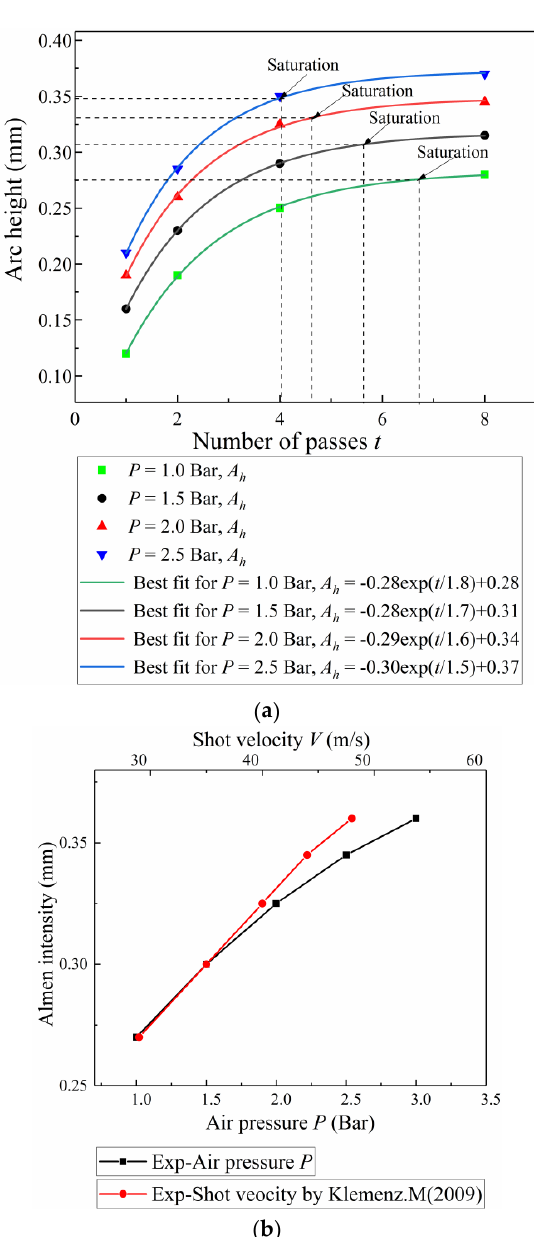
Figure 10. Almen intensity test. ( a ) Saturation curves of Almen strips with different air pressures for normal impact. ( b ) Relationship between the Almen intensity and air pressure, shot velocity by formula introduced by Klemenz. M